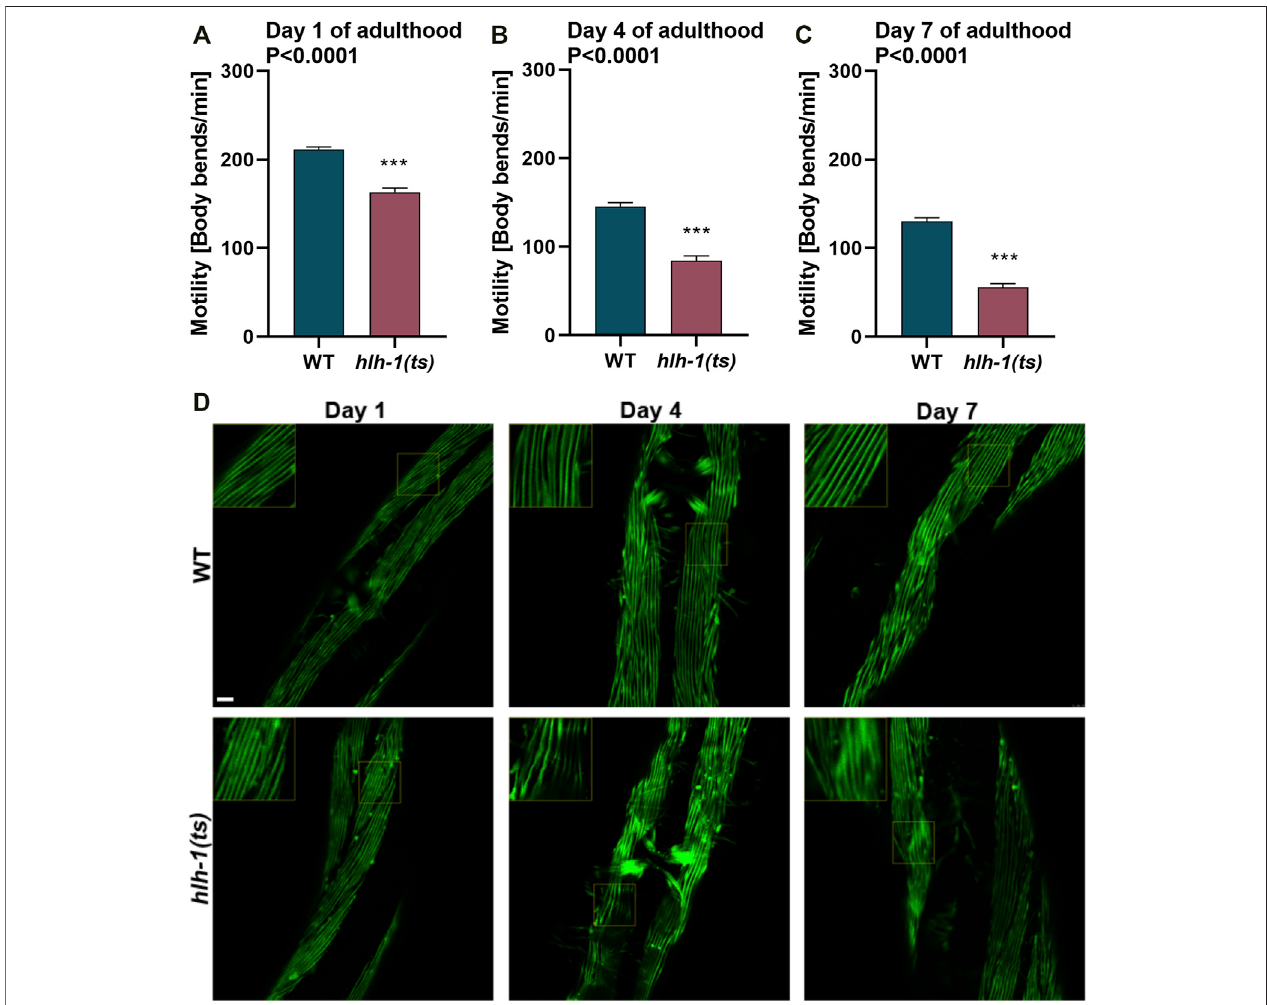
FIGURE 4 | Mild disruption of hlh-1 expression during development severely impact muscle maintenance later in adulthood. (A – C) Motility rates of WT or hlh-1(ts) adults. Thrashing rates of age-synchronized WT or hlh-1(ts) animals maintained at 15 ° C were examined on days 1 (A) , 4 (B) , or 7 (C) of adulthood. Data are means ± 1 standard error ofthe mean (1SE). Data were analyzed using theWilcoxonMann-Whitney rank sum test compared with WT (N = 3, n ≥ 30). (D) Representative images of WT or hlh-1(ts) animals that express MYO-3::GFP. Age-synchronized WT or hlh-1(ts) animals maintained at 15 ° C were collected and fi xed on days 1, 4, or 7 of adulthood, and myo fi laments were imaged. Inserts are a 2-fold magni fi cation of the boxed area. The scale bar is 10 μ m.